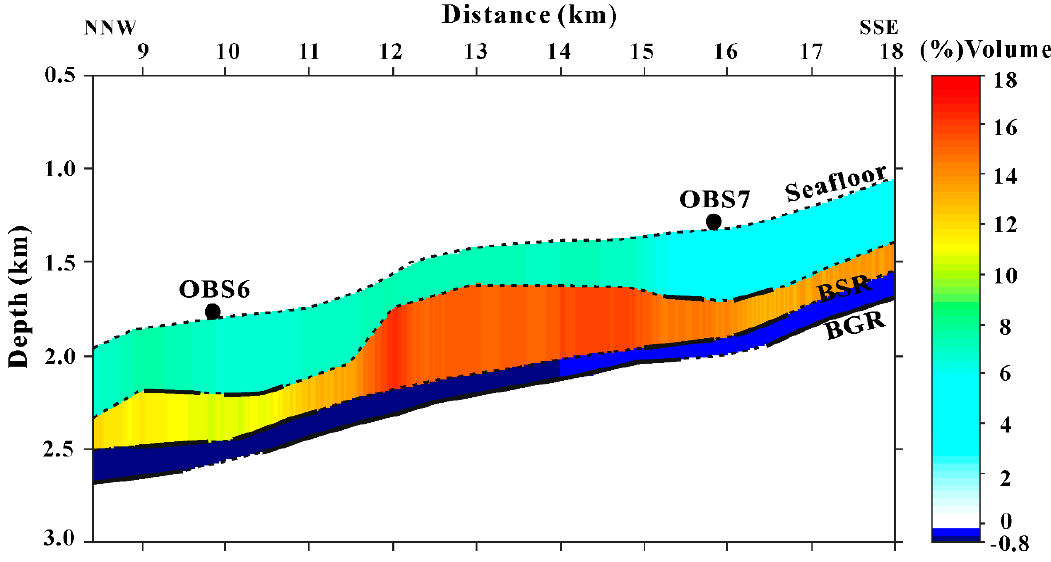
Figure 8. Concentration section of gas hydrate (positive values) and free gas (negative values).